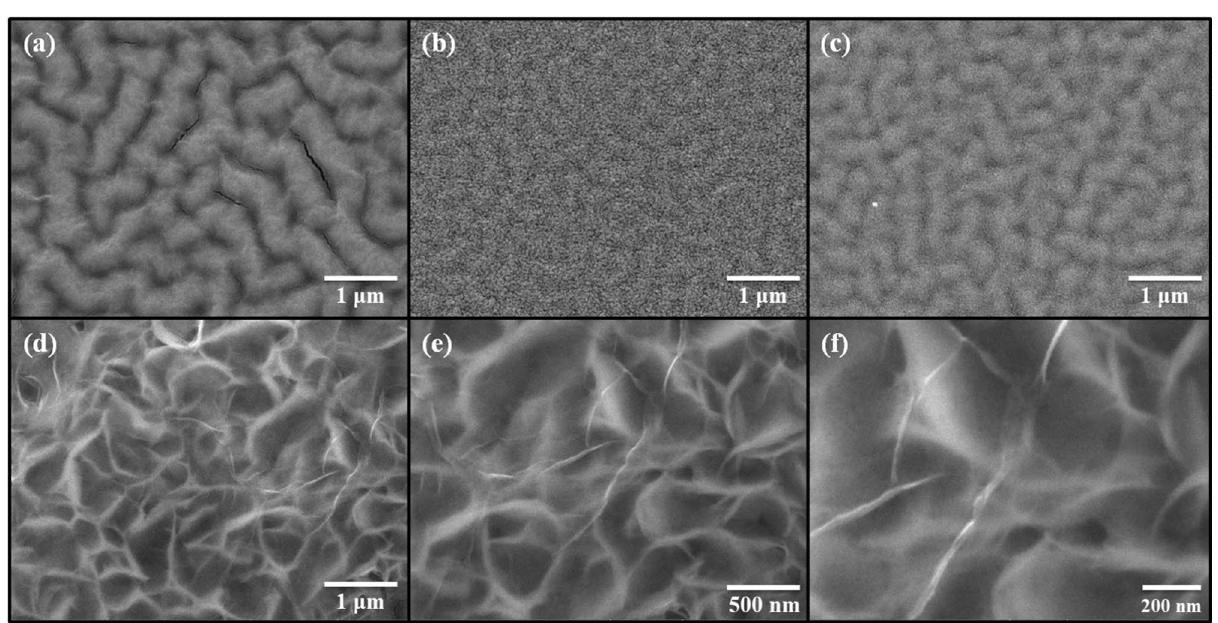
Figure 3. FE-SEM images of sol–gel spin-coated ZnO thin films annealed by using various method. (a) Non- annealed ZnO thin films, (b) furnace, (c) IR lamp, and (d–f) TDA